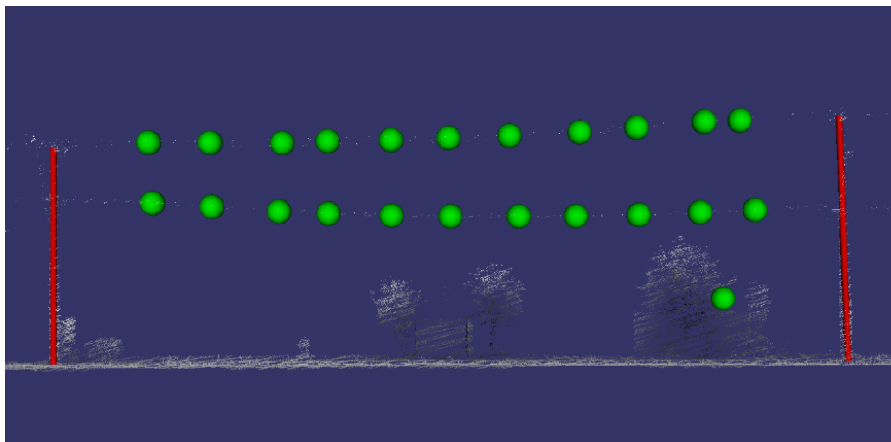
Figure 4. The remaining centre of masses after filtering. Note all the centre of masses belonging to the ground and the majority of the bush have been removed. The single bush centre of mass remaining fell in a separate window to the rest of the object.